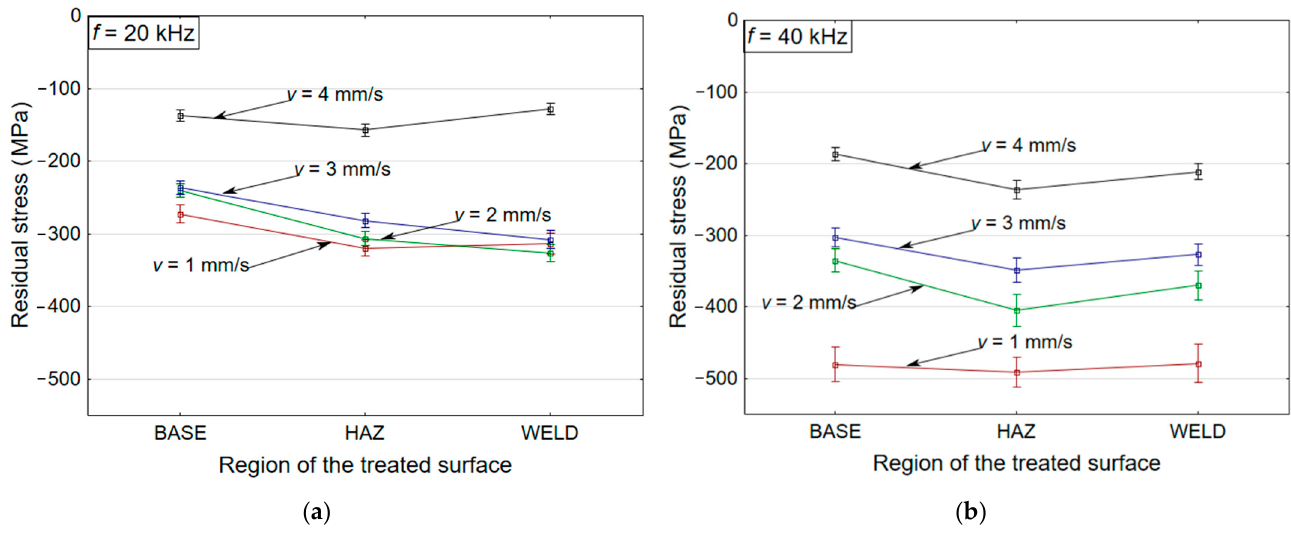
Figure 3. Variation in the maximum principal residual stress with varying traverse speeds in the different zones of the welded joints at frequencies of ( a ) f = 20 kHz [17] and ( b ) f = 40 kHz.